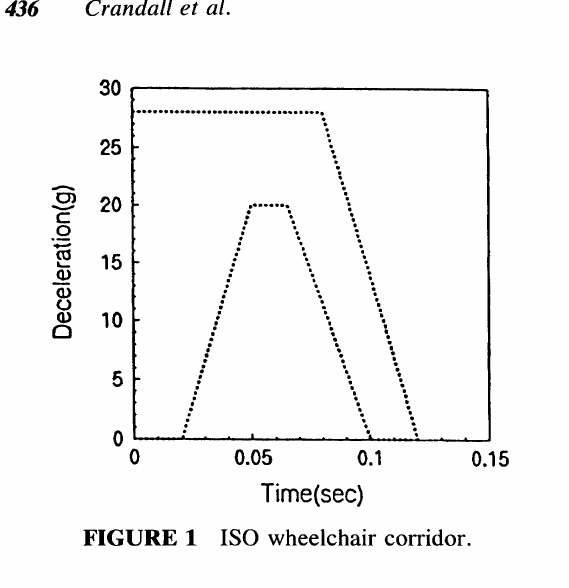
FIGURE 1 ISO wheelchair corridor.